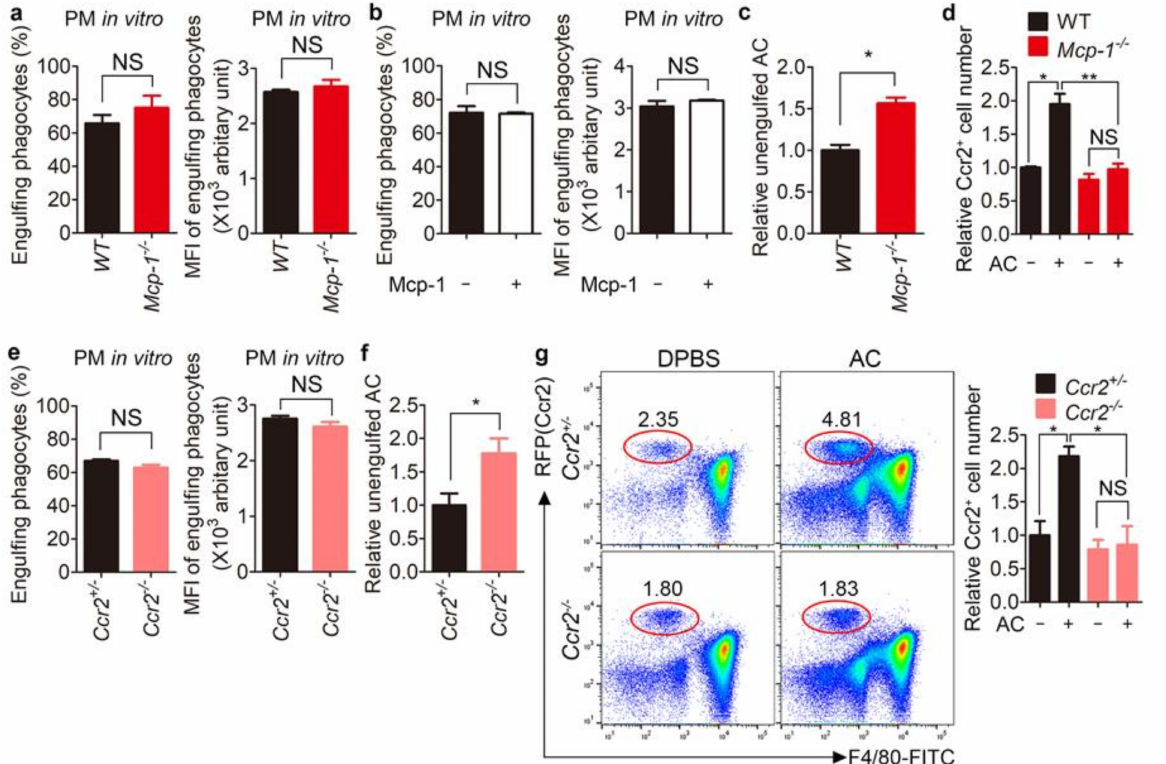
Figure 4. Clearance of apoptotic cells is impaired in Mcp-1 − / − and Ccr2 − / − mice. ( a ) Peritoneal macrophages derived from WT or Mcp-1 − / − mice were incubated with TAMRA-labeled apoptotic thymocytes for 15 min. The percentages and MFIs of phagocytes engulfing apoptotic cells were measured by flow cytometry. ( b ) Peritoneal macrophages were incubated with TAMRA-labeled apoptotic thymocytes in the absence or presence of pure Mcp-1 for 15 min. Phagocytes engulfing apoptotic cells were analyzed by flow cytometry. ( c ) TAMRA-labeled apoptotic thymocytes were intraperitoneally injected into WT or Mcp-1 − / − mice. Two hours after injection, peritoneal exudates were collected, stained with an anti-F4/80 antibody, and analyzed by flow cytometry. The relative number of TAMRA-positive and F4/80-negative cells per counting bead was determined. ( d ) Apoptotic thymocytes were intraperitoneally injected into WT or Mcp-1 − / − mice. Two hours after injection, peritoneal exudates were stained with an anti-Ccr2 antibody and analyzed by flow cytometry. The relative number of Ccr2-positive cells per counting bead was determined. ( e ) Peritoneal macrophages derived from Ccr2 + / − or Ccr2 − / − mice were incubated with CellTracker-labeled apoptotic thymocytes and analyzed by flow cytometry. ( f ) CellTracker-labeled apoptotic thymocytes were intraperitoneally injected into Ccr2 + / − or Ccr2 − / − mice. Two hours after injection, peritoneal exudates were stained with an anti-F4/80 antibody and analyzed by flow cytometry. The relative number of CellTracker- positive and F4/80-negative cells per counting bead was determined. ( g ) Apoptotic thymocytes were intraperitoneally injected into Ccr2 + / − or Ccr2 − / − mice. Two hours after injection, peritoneal exudates were collected and stained with an anti-F4/80 antibody. The relative number of RFP-positive cells per counting bead was determined. Red circles indicate RFP (Ccr2)-positive cells. All data are shown as the mean ± SEM. * p < 0.05, ** p < 0.01. NS, not significant; PM, peritoneal macrophages; AC, apoptotic